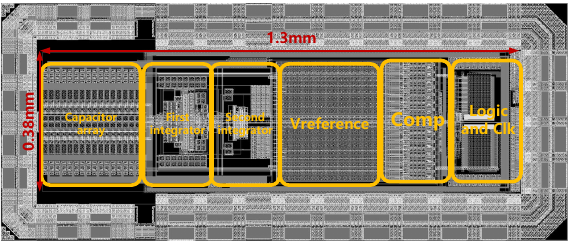
Figure 17. The layout circuit of the proposed modulator.